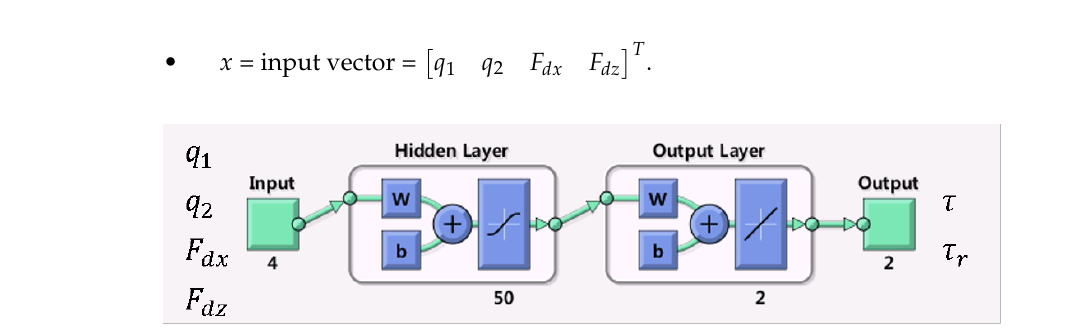
Figure 5. Neural network model for regression.